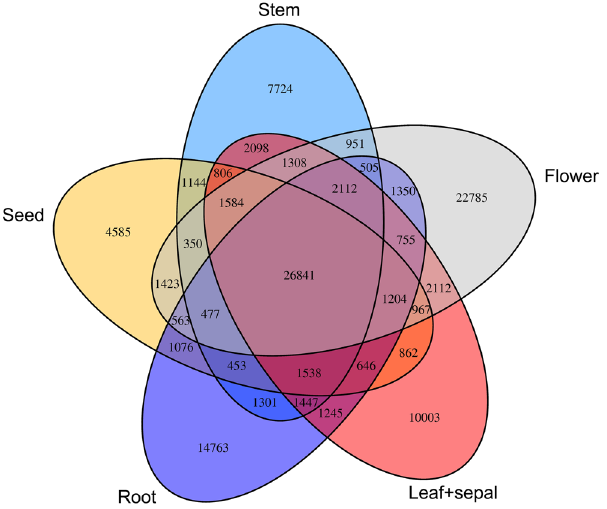
Figure 3. Pathway enrichment analysis in six organs. A significance threshold of P < 0.05 was considered statistically